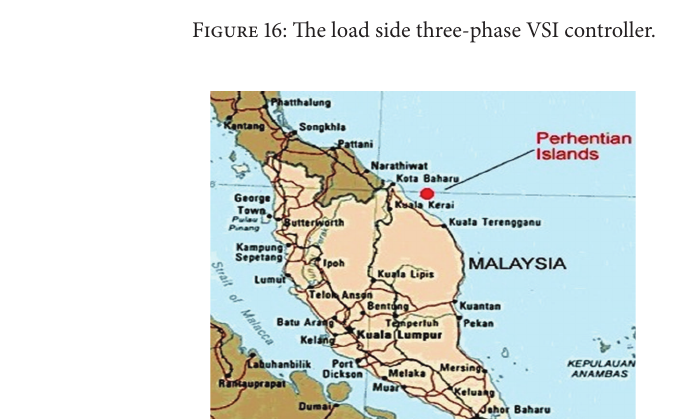
Figure 16: The load side three-phase VSI controller.